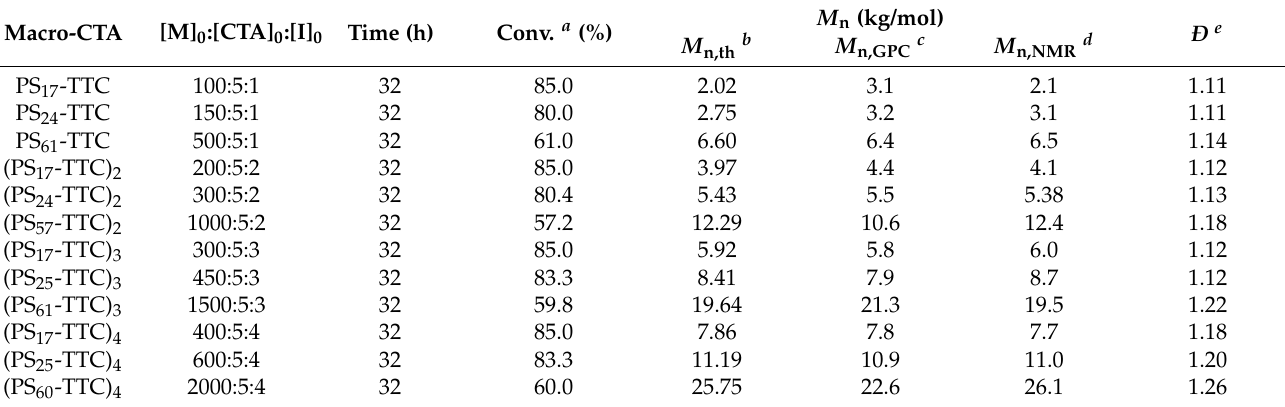
Table 1. Summary of the Synthesized